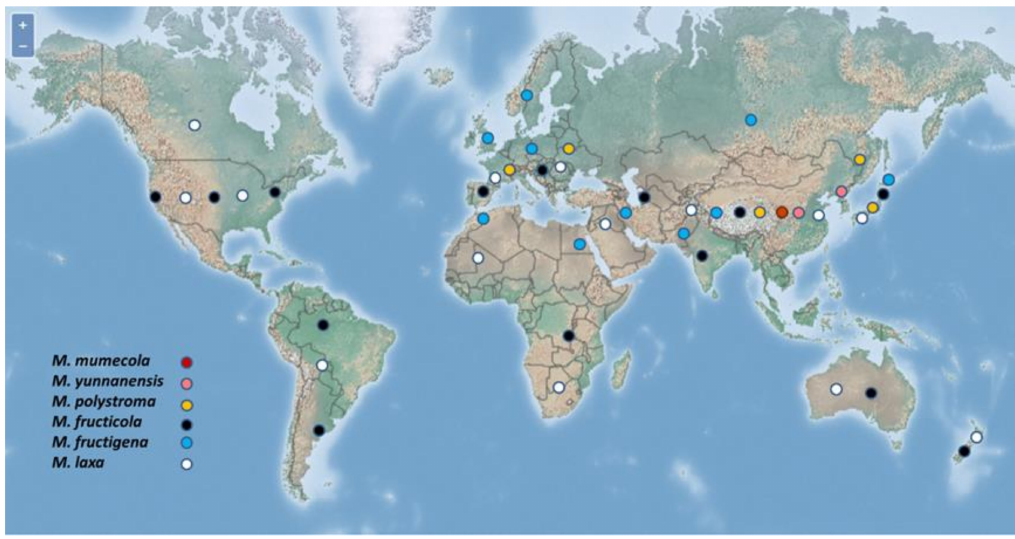
Figure 4. Global map showing the present continental distribution of the species of Monilinia spp . Source: https://www.cabi.org/isc/